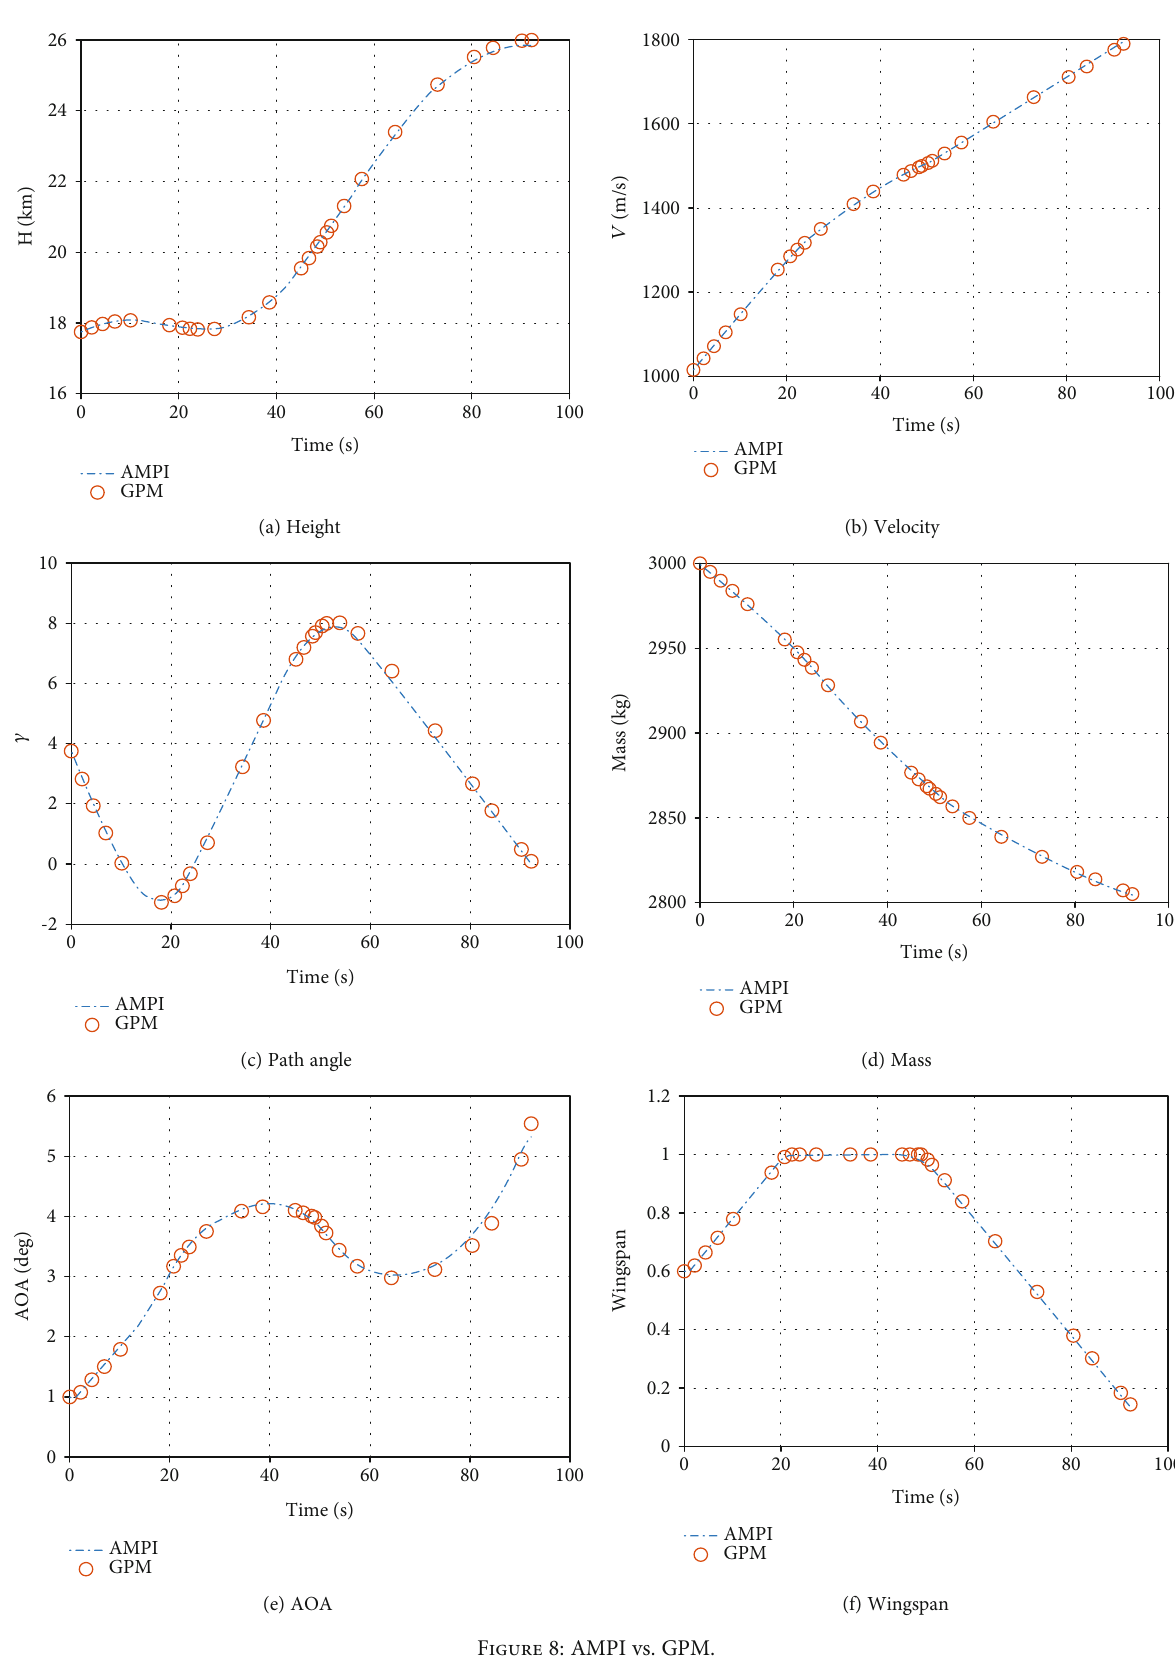
Figure 8: AMPI vs.